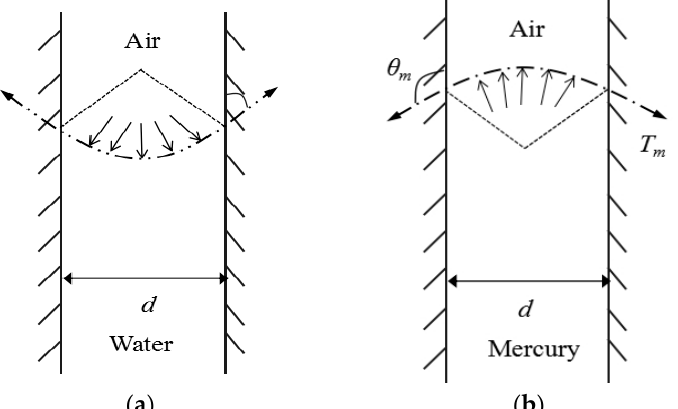
Figure 1. Schematic diagram of an air-water interface and a mercury-air interface. ( a ) air-water interface; ( b ) mercury-air interface.